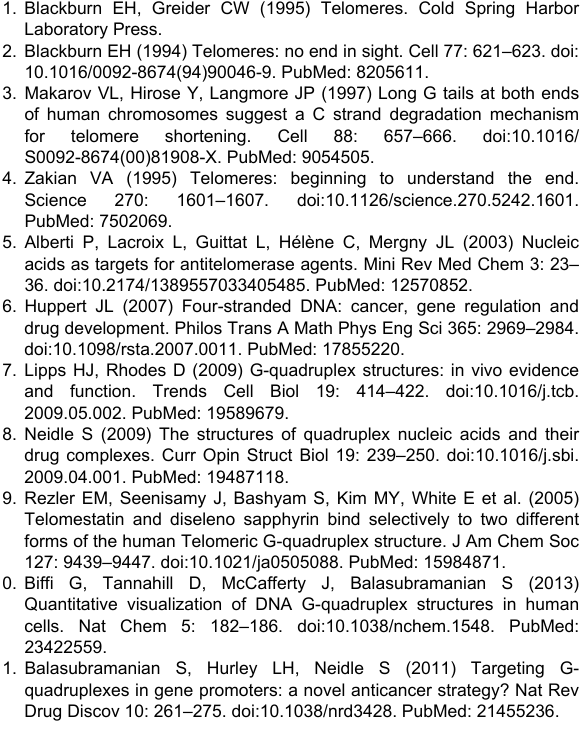
(TIF) Figure S2. Binding stoichiometry with G-quadruplex investigated through luminescence. Job plot using luminescence data for [(dmb) Ru(obip)Ru(dmb) ] 4+ with G- 2 2 quadruplex at 10 uM final using 100 mM NaCl, 10 mM that of complex added to DNA. (TIF) Figure S3. Molecular docking of complex and duplex DNA. Minimized model of complex between [(dmb) Ru(obip)Ru(dmb) ] 4+ and duplex DNA. The G is colored 2 2 in green yellow, the A is colored in red, the T is colored in cyan and [(dmb) Ru(obip)Ru(dmb) ] 4+ is colored in brown and blue. 2 2 (TIF) Table S1. MTT results analysis with GraphPad Prism5 Two-way RM ANOVA (Bonferroni